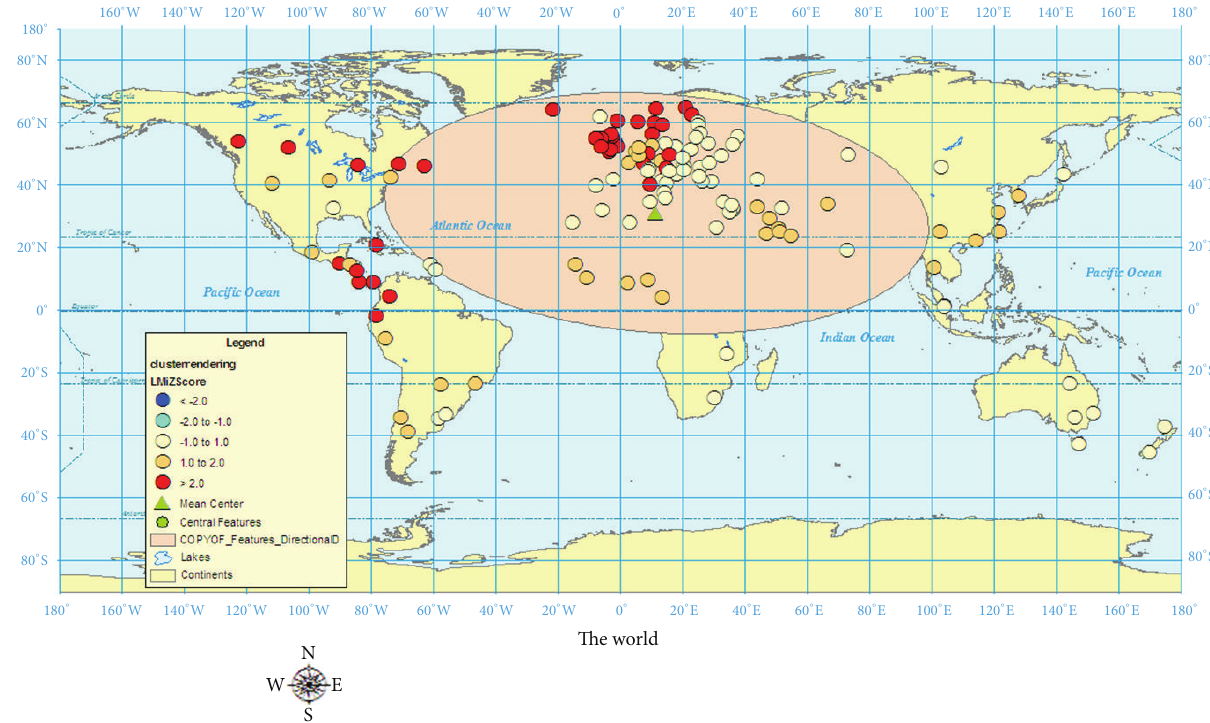
Figure 3: World map of MS prevalence with cluster rendering and directional distribution using 131 geocases.